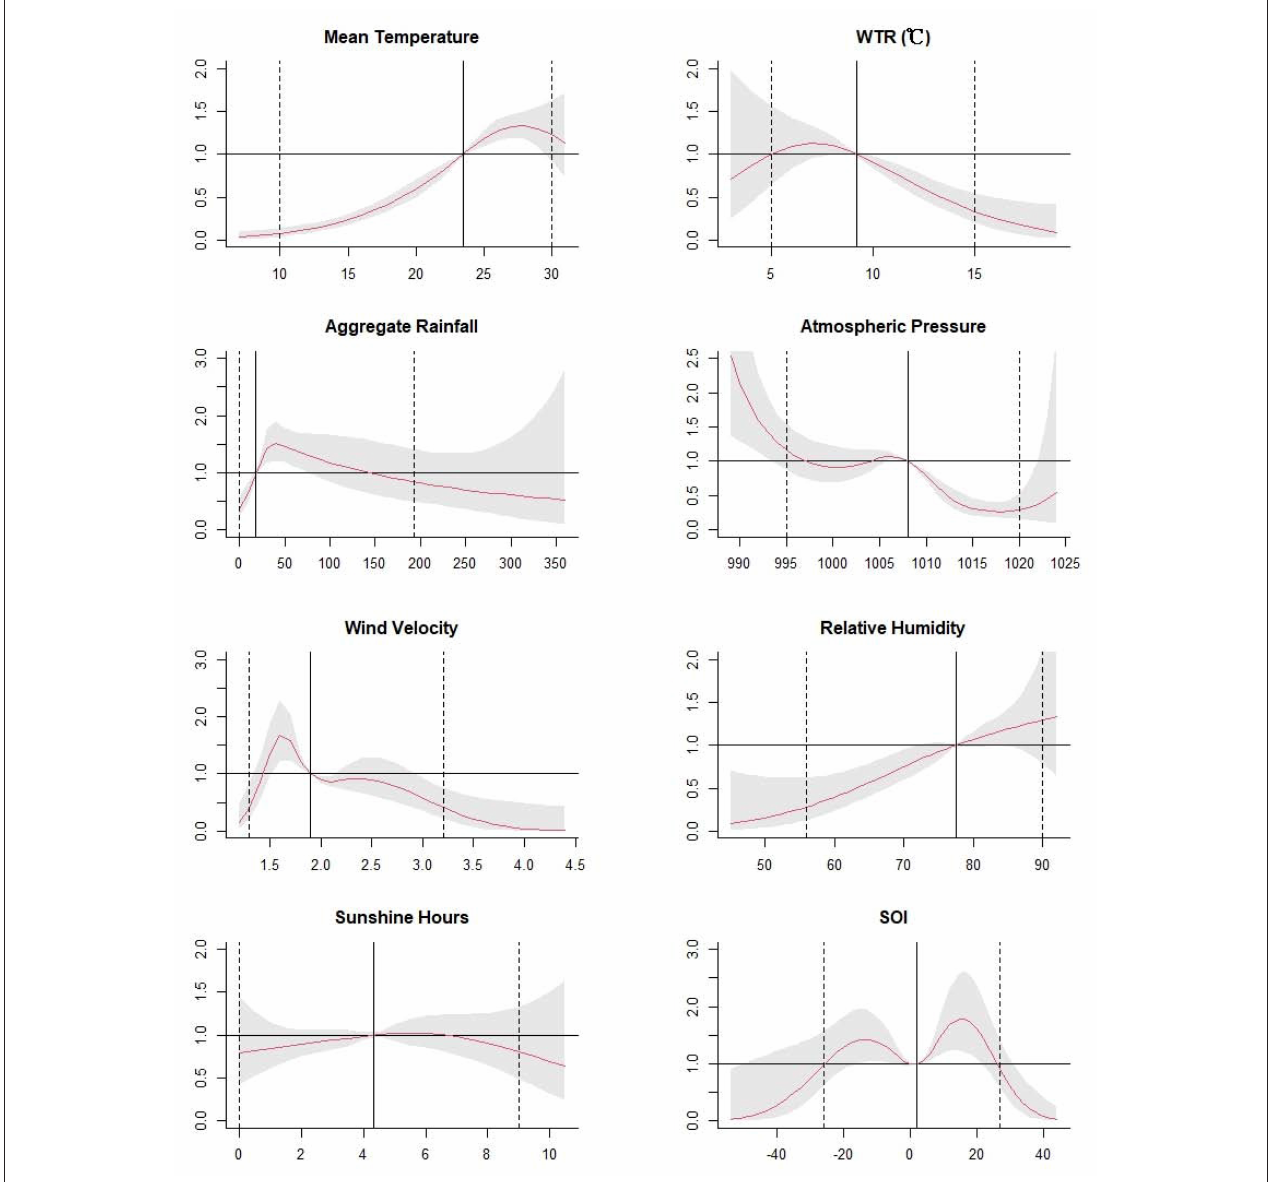
FIGURE 3 | The estimated overall effects of mean temperature, weekly temperature range, aggregate rainfall, atmospheric pressure, relative humidity, wind velocity and sunshine hours, and SOI over 14 weeks. The Y lab represents the value of relative risk, the X lab represents the value of relevant variables. The red lines represent mean relative risks and the gray regions represent 95% CIs. The black vertical line represents the medians of the climatic factors and the SOI, and the dotted lines represent the 2.5 percentile and the 97.5 percentile for the climatic factors and the SOI, respectively.